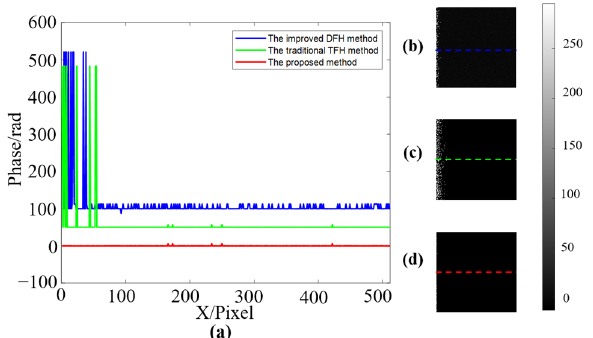
Figure 8. Comparison of the plane phases obtained by the three methods for a virtual plane. ( a ) Phase profiles of the three methods (each line shifts 50 rad for clarity, and the color corresponds to the right). ( b – d ) are the normalized plane phases recovered by the improved DFH method, the traditional TFH method, and the proposed method, respectively.